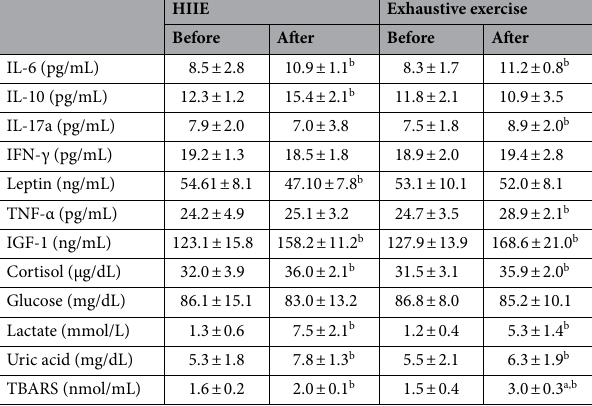
Table 1. The effect of HIIE and exhaustive exercise in serum biomarkers before and immediately after exercise. Data are presented as mean ± standard deviation. a Denotes between groups difference ( p < 0.05). b Denotes statistical difference compared to before exercise ( p < 0.05).